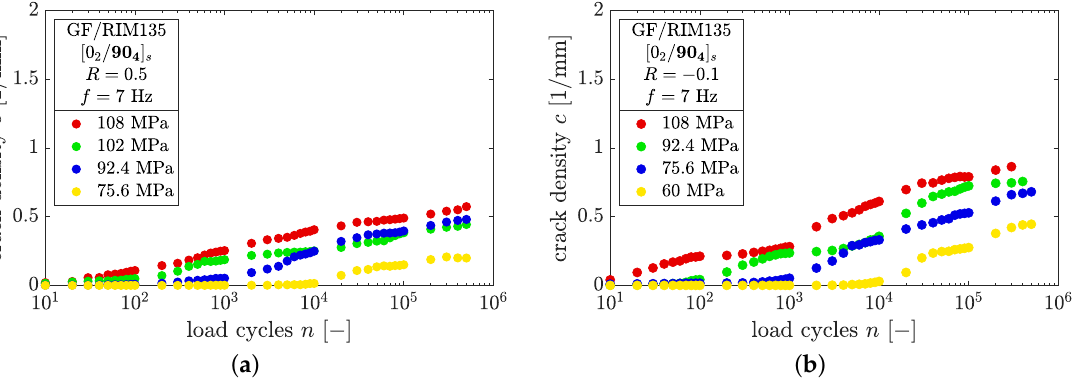
Figure A1. Results of the crack counting procedure for [ 0 2 /90 4 ] s -laminates for ( a ) R = 0.5 and ( b ) R = − 0.1.